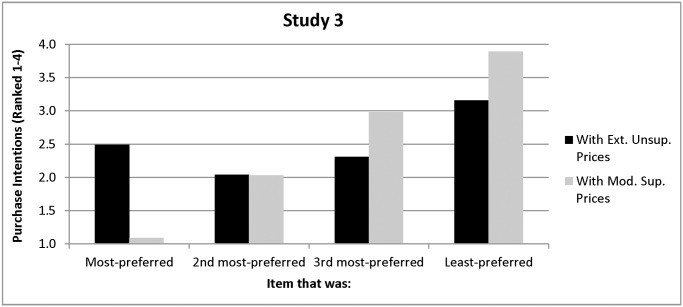
Purchase Intentions as a Function of Preferences in Study 3.